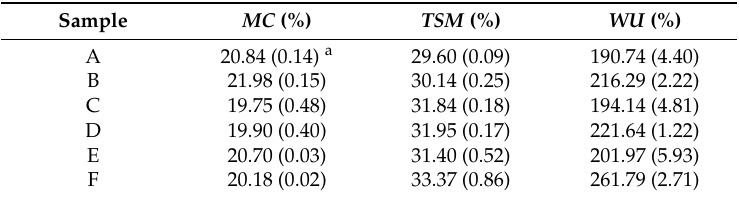
Table 4. The moisture content ( MC ), total soluble matter ( TSM ) and water uptake of different SPI-based films.